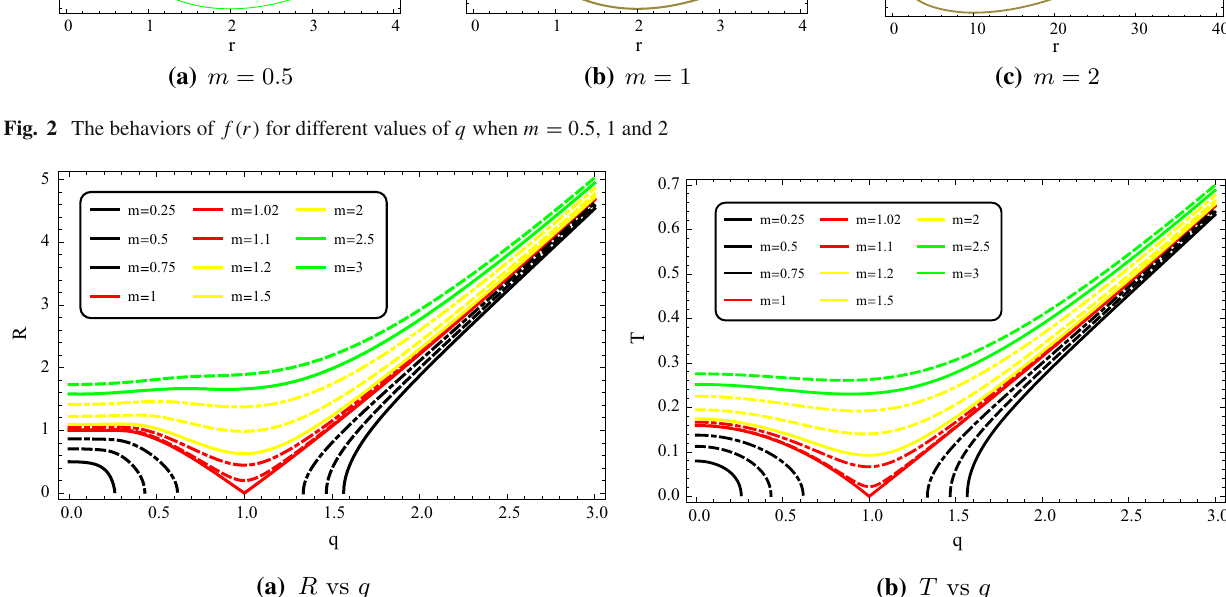
Fig. 3 The behaviors of distance R between inner and outer horizons ( left ) and the temperature T ( right ) of charged BTZ black hole